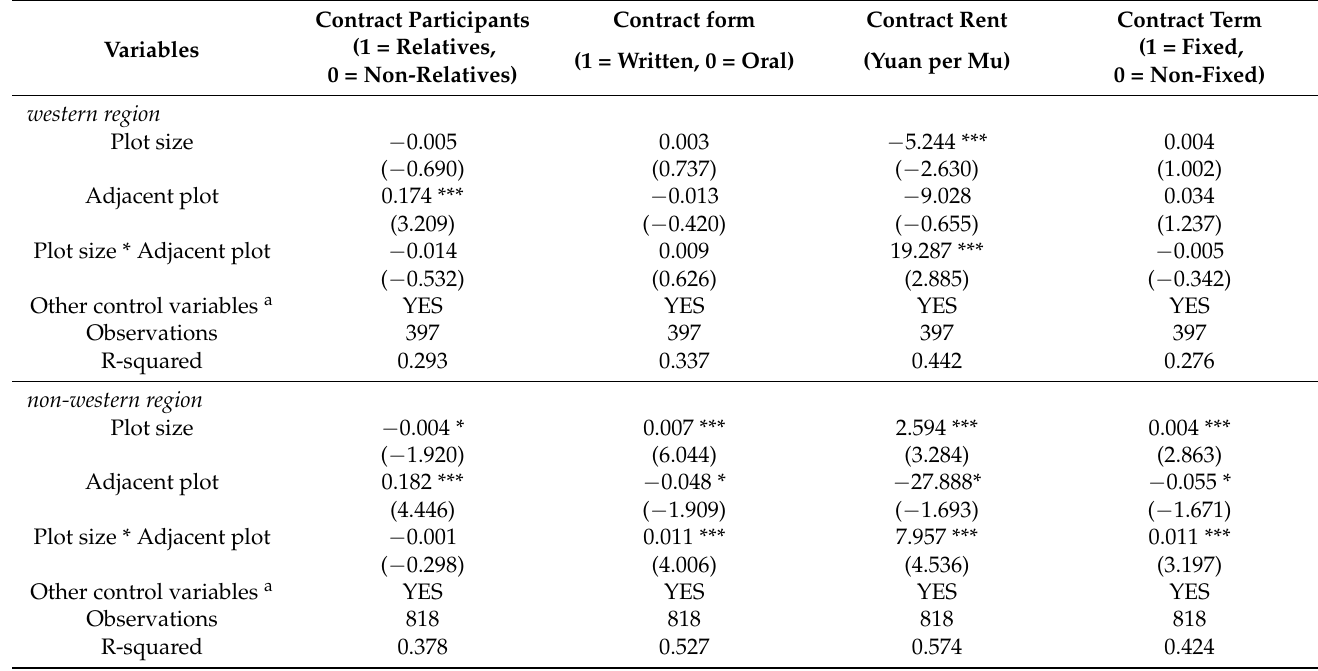
Table 7. The impact of the characteristics of rented-in plots on the contract choice in the western region and non-western region, seemingly unrelated